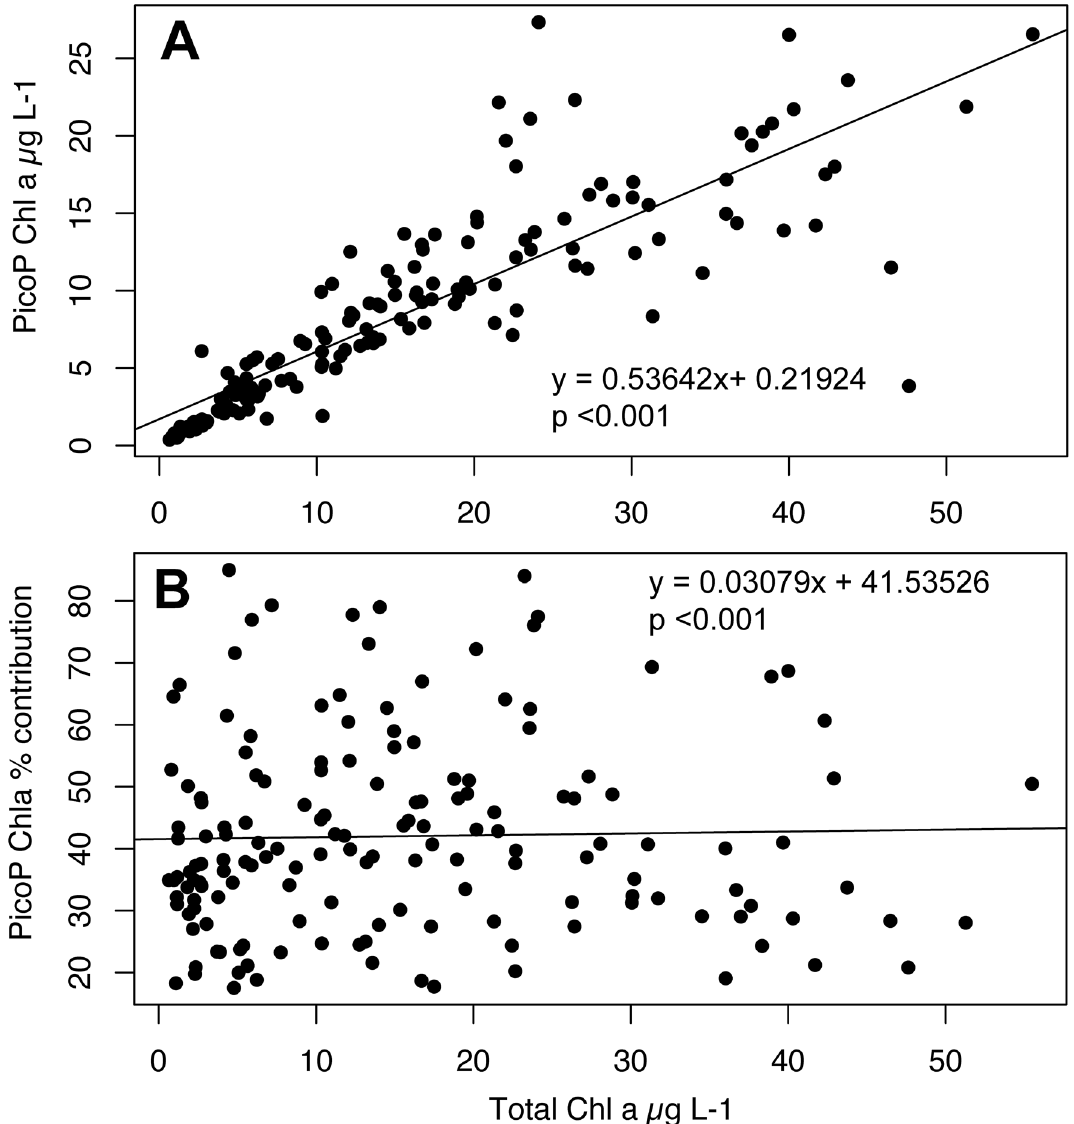
Figure 6. ( A ) PicoP Chl a concentration and ( B ) % PicoP Chl a concentration versus total Chl a concentration from six NRE stations across the freshwater to marine continuum (see “Methods”). Non-parametric linear regressions are presented and both plots were generated using R 52